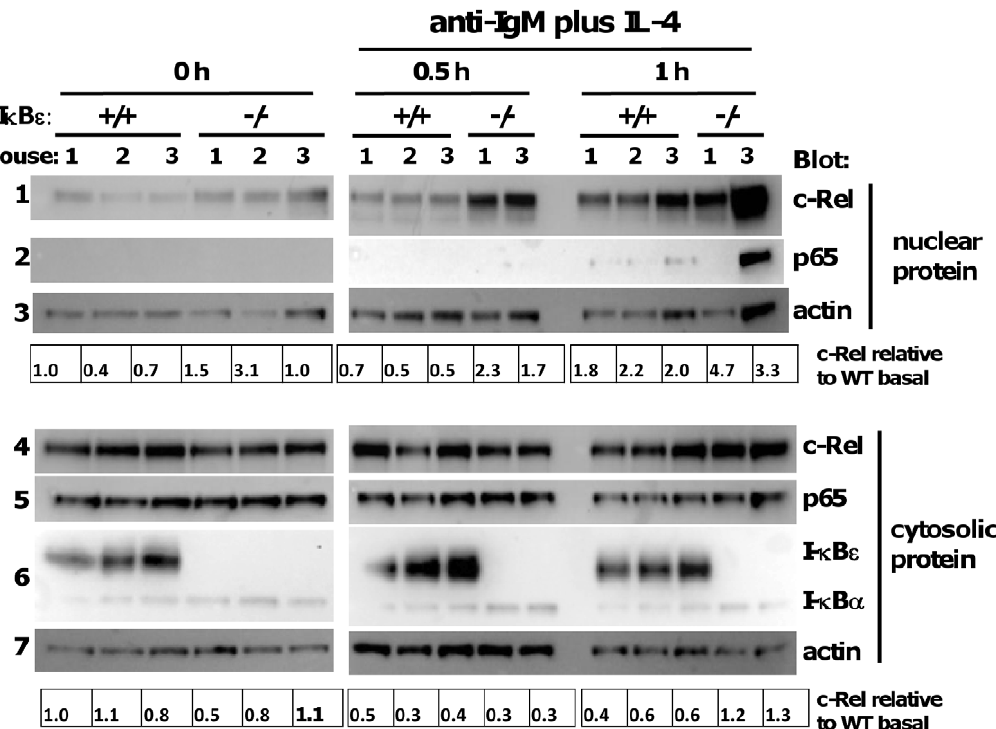
Figure 7. Increased basal and BCR-inducible nuclear c-Rel in I k B e 2 / 2 splenic B cells. Splenic B cells were isolated by CD19 positive selection from three each of I k B e + / + and I k B e 2 / 2 mice. (A) Cells were rested for 2 hours then stimulated with anti-IgM F(ab’) 2 fragment 10 m g/ml for the times indicated at 10 7 B cells/ml per condition in a 12-well plate. There were insufficient cells from I k B e 2 / 2 mouse 2, following selection, to carry out stimulation of its B cells. Nuclear and cytoplasmic extracts from resting and stimulated cells were analysed for nuclear NF- k B and I k B by immunoblot. Nuclear and cytoplasmic c-Rel were normalised to actin and expressed relative to values for B cells of I k B e + / + mouse 1 (mouse numbers allocated randomly), as